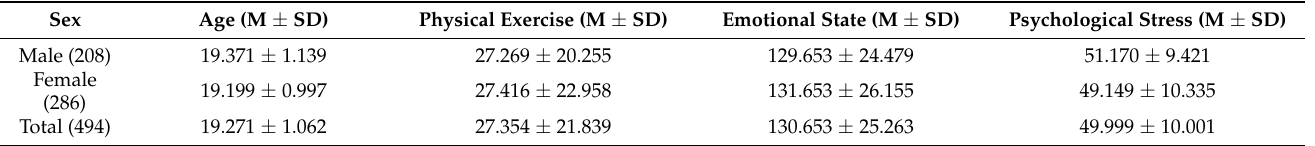
Table 1. Descriptive statistics of each